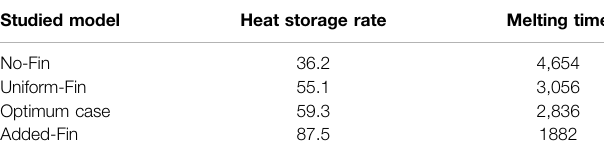
TABLE6| ThetotalheatstoragerateandmeltingtimeforvariouscasesofNo-Fin, Uniform-Fin, Optimum case, and Added-Fin. Studied